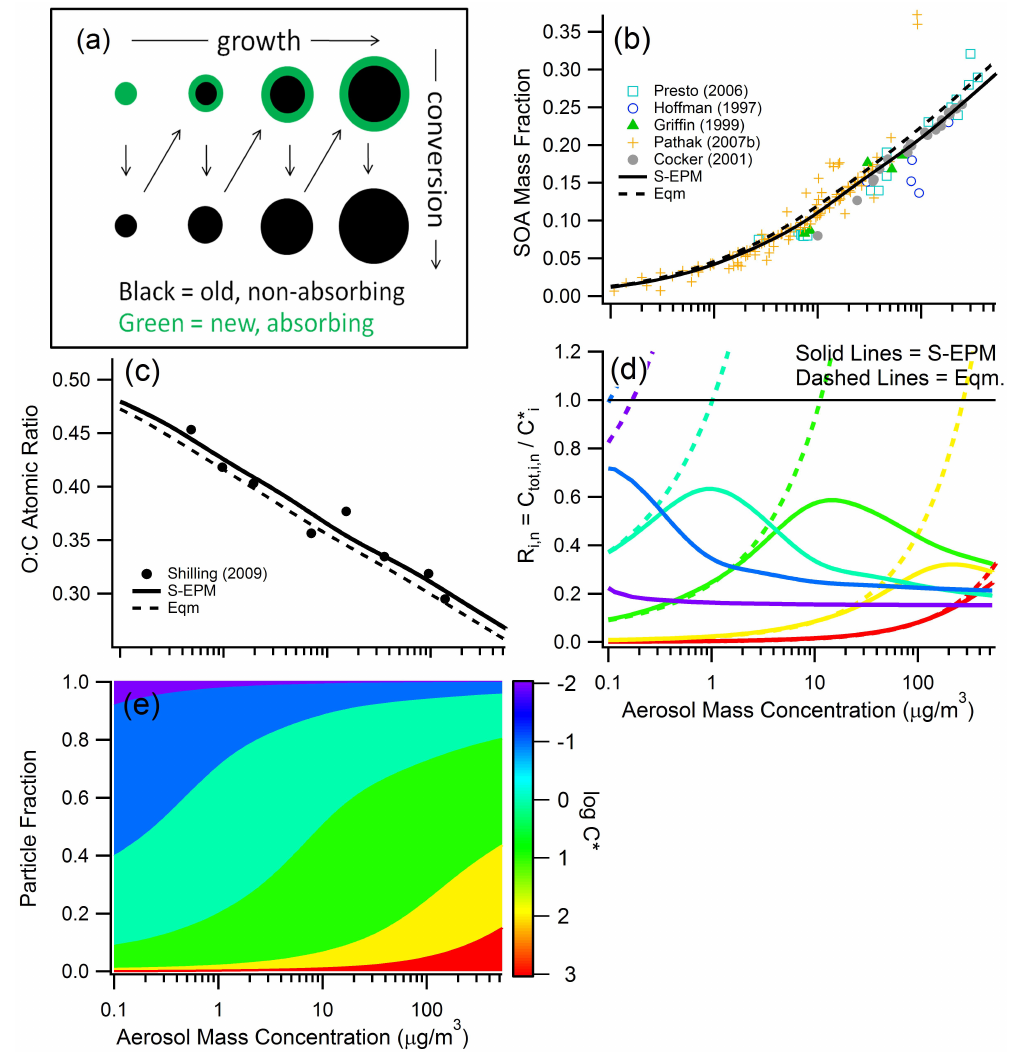
Fig. 6. (a) A schematic of the processes in the S-EPM. Up to down (and green to black) represents conversion of the previously absorbing phase into a non-absorbing (glassy) phase. Diagonal (down-to-up/left-to-right) represents particle growth and the formation of a new ab- sorbing phase. (b) The calculated aerosol yield from the sequential partitioning model is shown (solid line) along with the measurements for α -Pinene+O 3 from Hoffman et al. (1997); Griffin et al. (1999); Cocker et al. (2001); Presto et al. (2006), and Pathak et al. (2007b). Results from a traditional equilibrium partitioning model using the same volatility basis-set as for the S-EPM are shown for comparison (dashed line). (c) The calculated O:C from the S-EPM (solid line) and the equilibrium (dashed line) models are shown along with the observations from Shilling et al. (2009). Note that the variation in O:C with C ∗ has been adjusted to give good model/measurement agreement. (d) The calculated variation in R i,n , i.e. the total mass concentration of each compound relative to its saturation concentration, as a function of C OA for both the S-EPM (solid lines) and the traditional model (dashed lines). Only material available for partitioning is included in C tot ,i,n . Line colors indicate components with different C ∗ , and are given in the color bar. (e) The relative particle fraction of each compound as a function of C OA . Colors correspond to C ∗